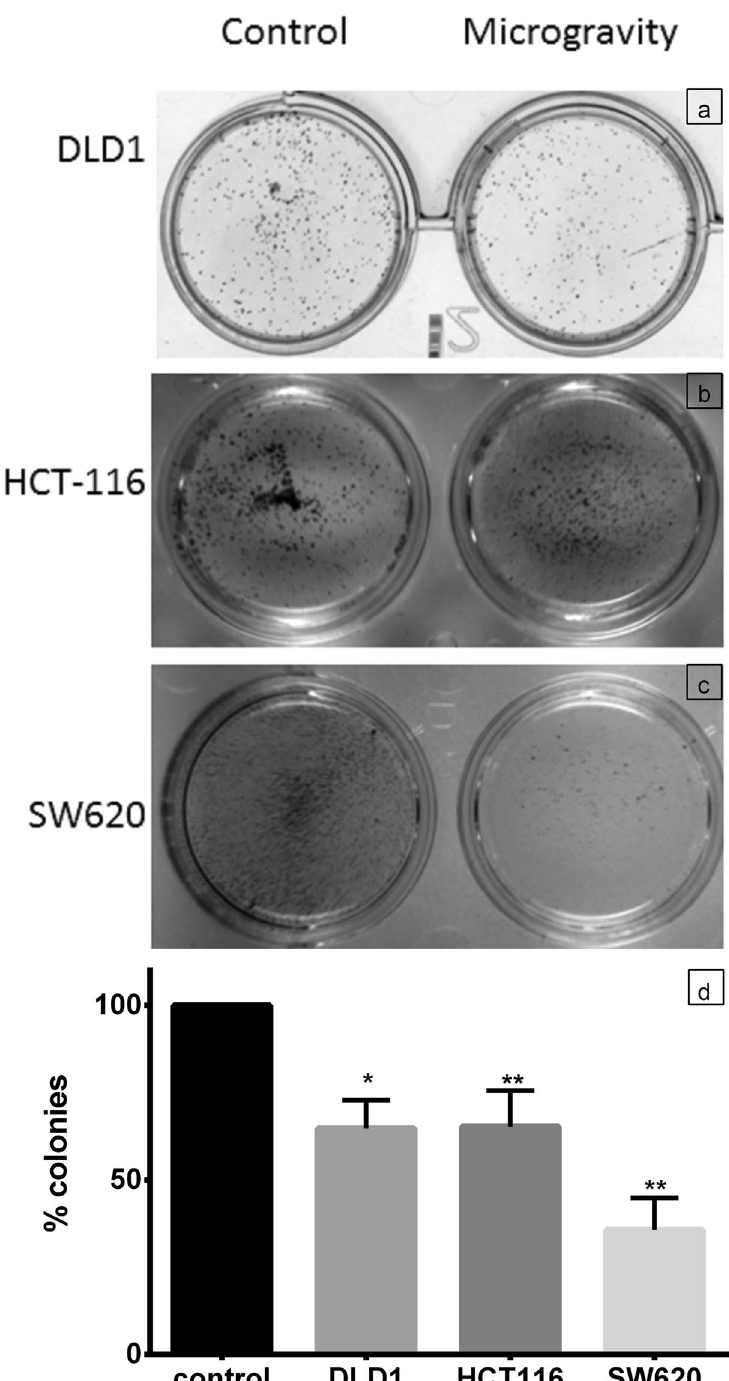
Figure 4. Cell growth is hindered with SM which results in reduced colony formation. The phase contrast image of colonies formed with 1000 cells in a 24 well plate for control and SM cells of DLD1 ( a ), HCT116 ( b ) and SW620 ( c ) show the reduced number of colonies in simulated microgravity. The data representation as mean + S.D. ( d ) depicts the reduction in percentage of colonies formed. The experiment was repeated thrice, data shows that colony formation was significantly reduced. P < 0.005 for HCT 116 and SW620, while P < 0.05 for